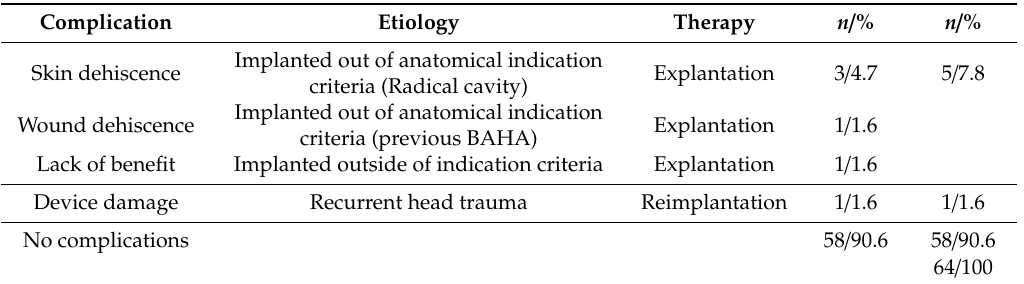
Table 2. Revisions and explantations.